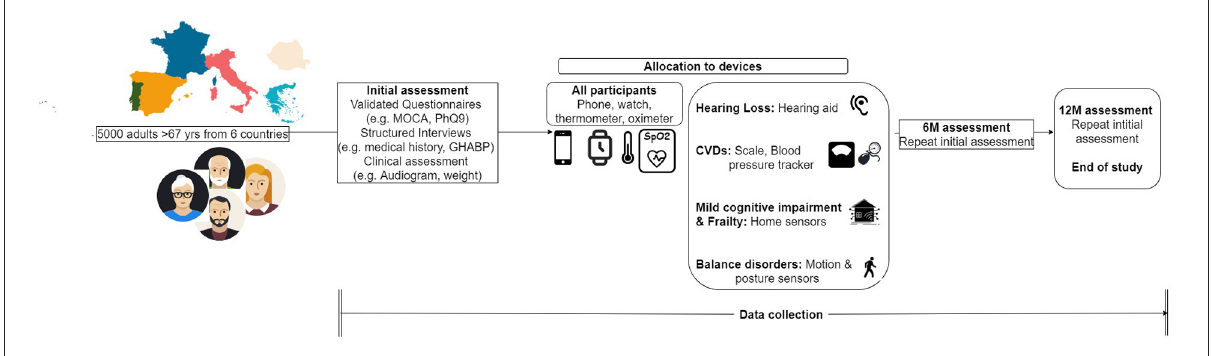
FIGURE1 Participants’ flow of